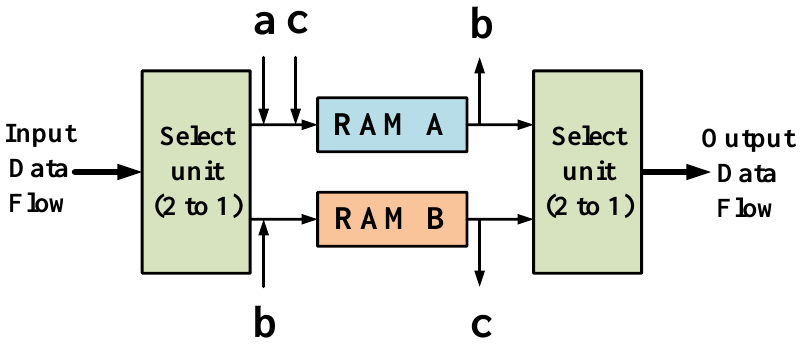
Figure 10. Ping-pong cache description.